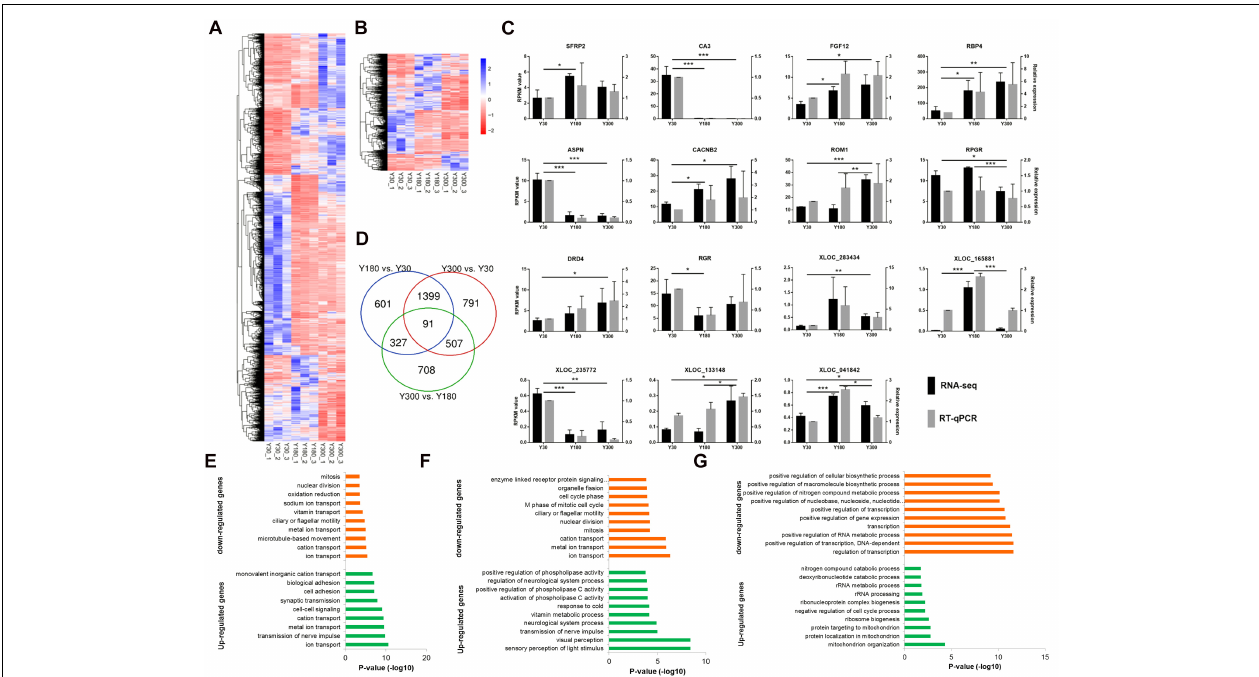
FIGURE 4 | Differential expression analysis of mRNAs and lncRNAs during porcine postnatal pineal development. (A,B) Heatmap showing the differentially expressed mRNAs (A) and lncRNAs (B) during porcine postnatal pineal development. (C) Experimental validation of RNA-seq data by RT-qPCR. Gene expression differences between developmental stages were evaluated based on the RNA-Seq data using the edgeR package. Error bars are SEM, n = 3. ∗ P < 0.05, ∗∗ P < 0.01, ∗∗∗ P < 0.001. (D) Venn diagram showing the number of differentially expressed mRNAs and lncRNAs between different development stages. (E–G) GO biological process analysis of the up-regulated and down-regulated genes between Y180-Y30 (E) , Y300-Y30 (F) , and Y300-Y180 (G) .